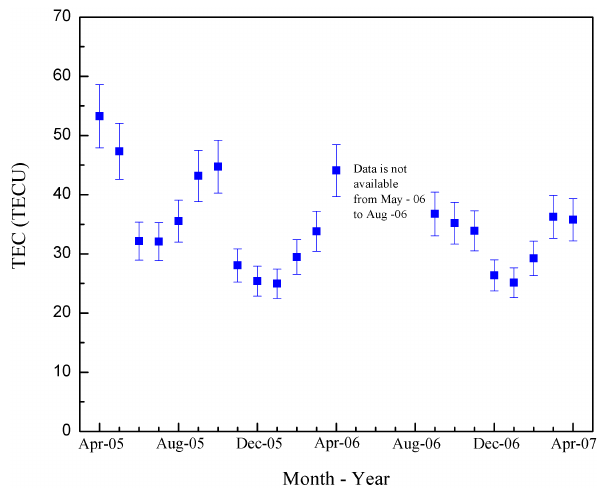
Fig. 4. Month-to-month Variation of TEC, daily mean peak, (2005– 2007) at Rajkot.